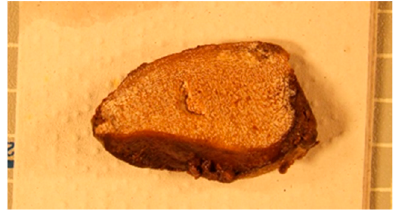
Figure A2. Transverse section of the right patella.